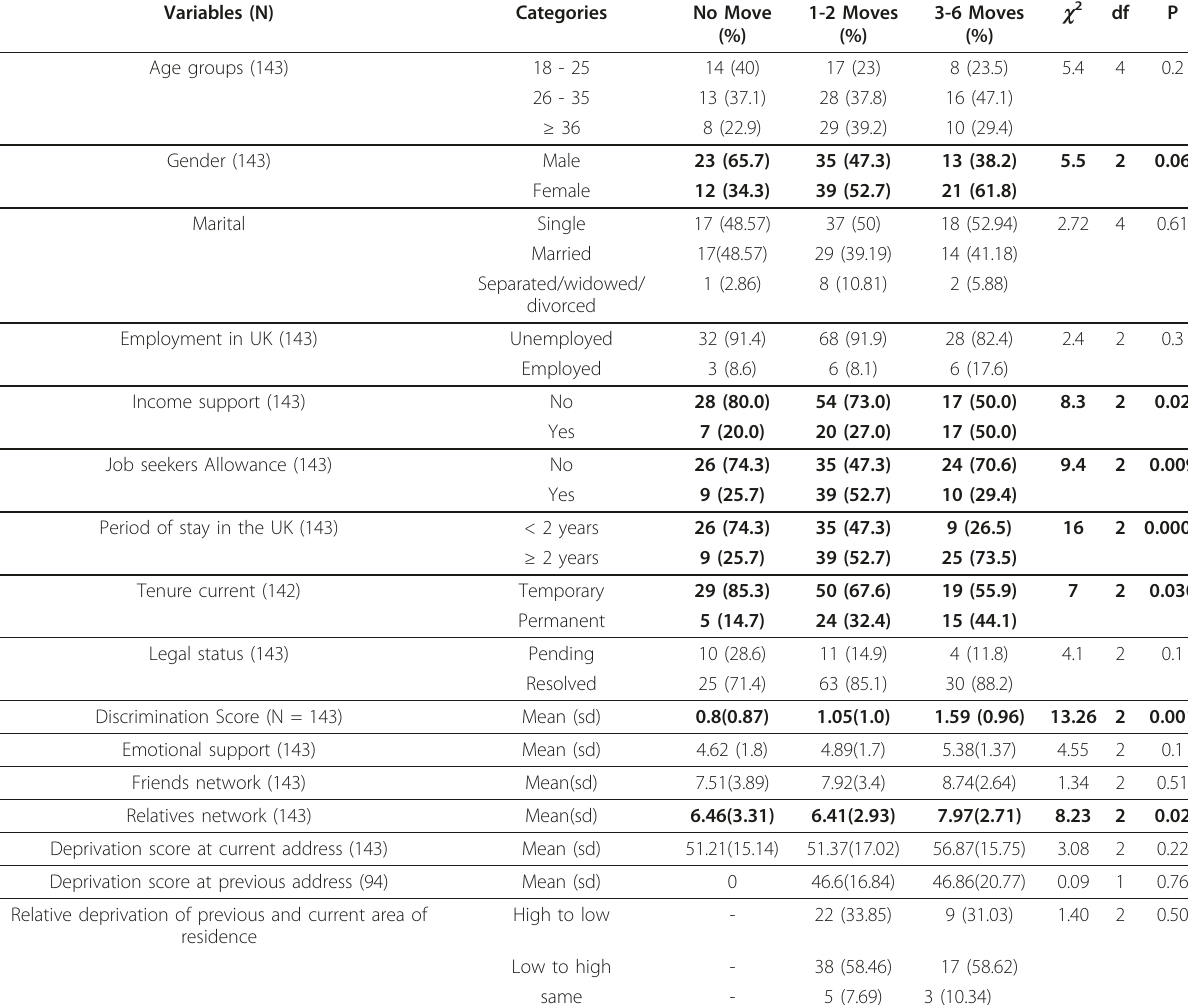
Table 1 Frequency of residential mobility: demographic, social, environpsychiatric, legal & health influences Variables